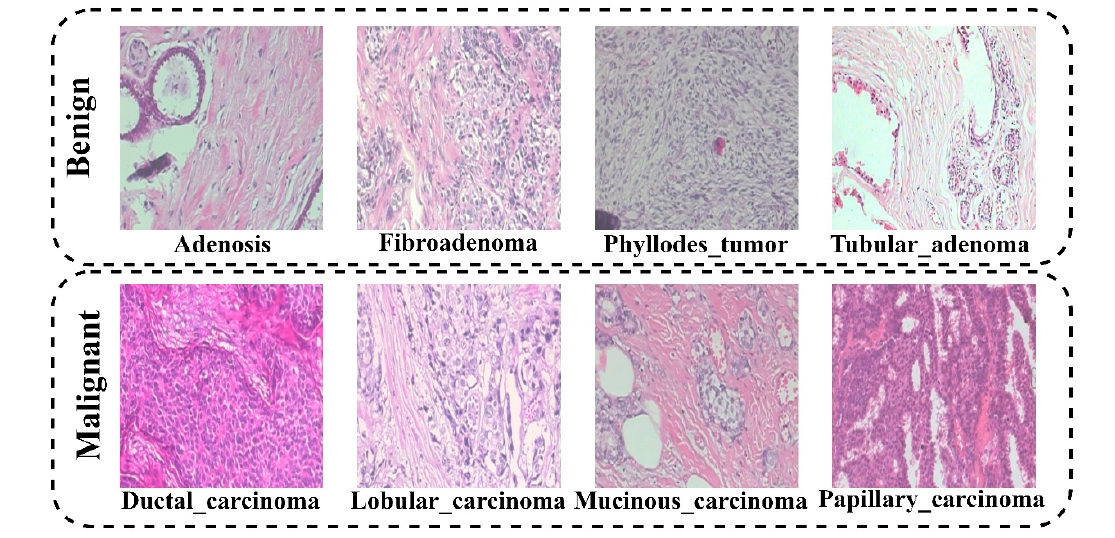
Figure 3. Visualization of the BreaKHis dataset. Table 3. BreaKHis dataset.